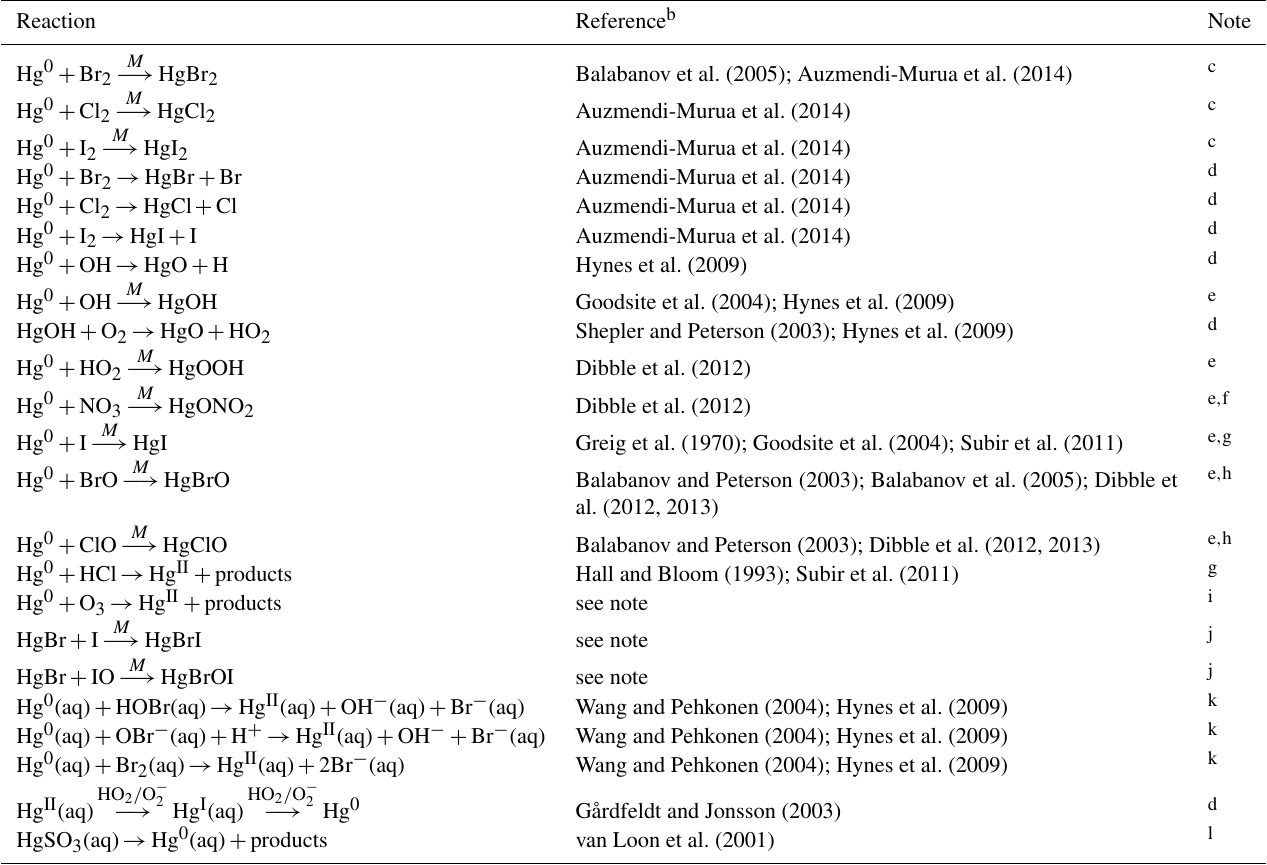
Table 2. Reactions not included in chemical mechanism a .